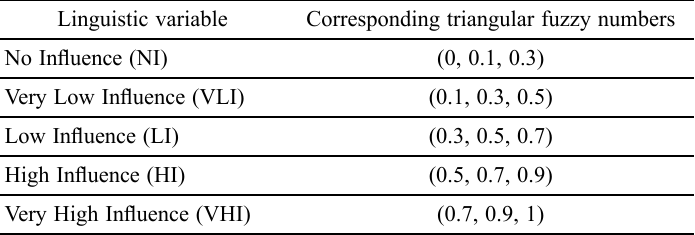
Table 2. Linguistic variable and corresponding triangular fuzzy numbers Linguistic variable Corresponding triangular fuzzy